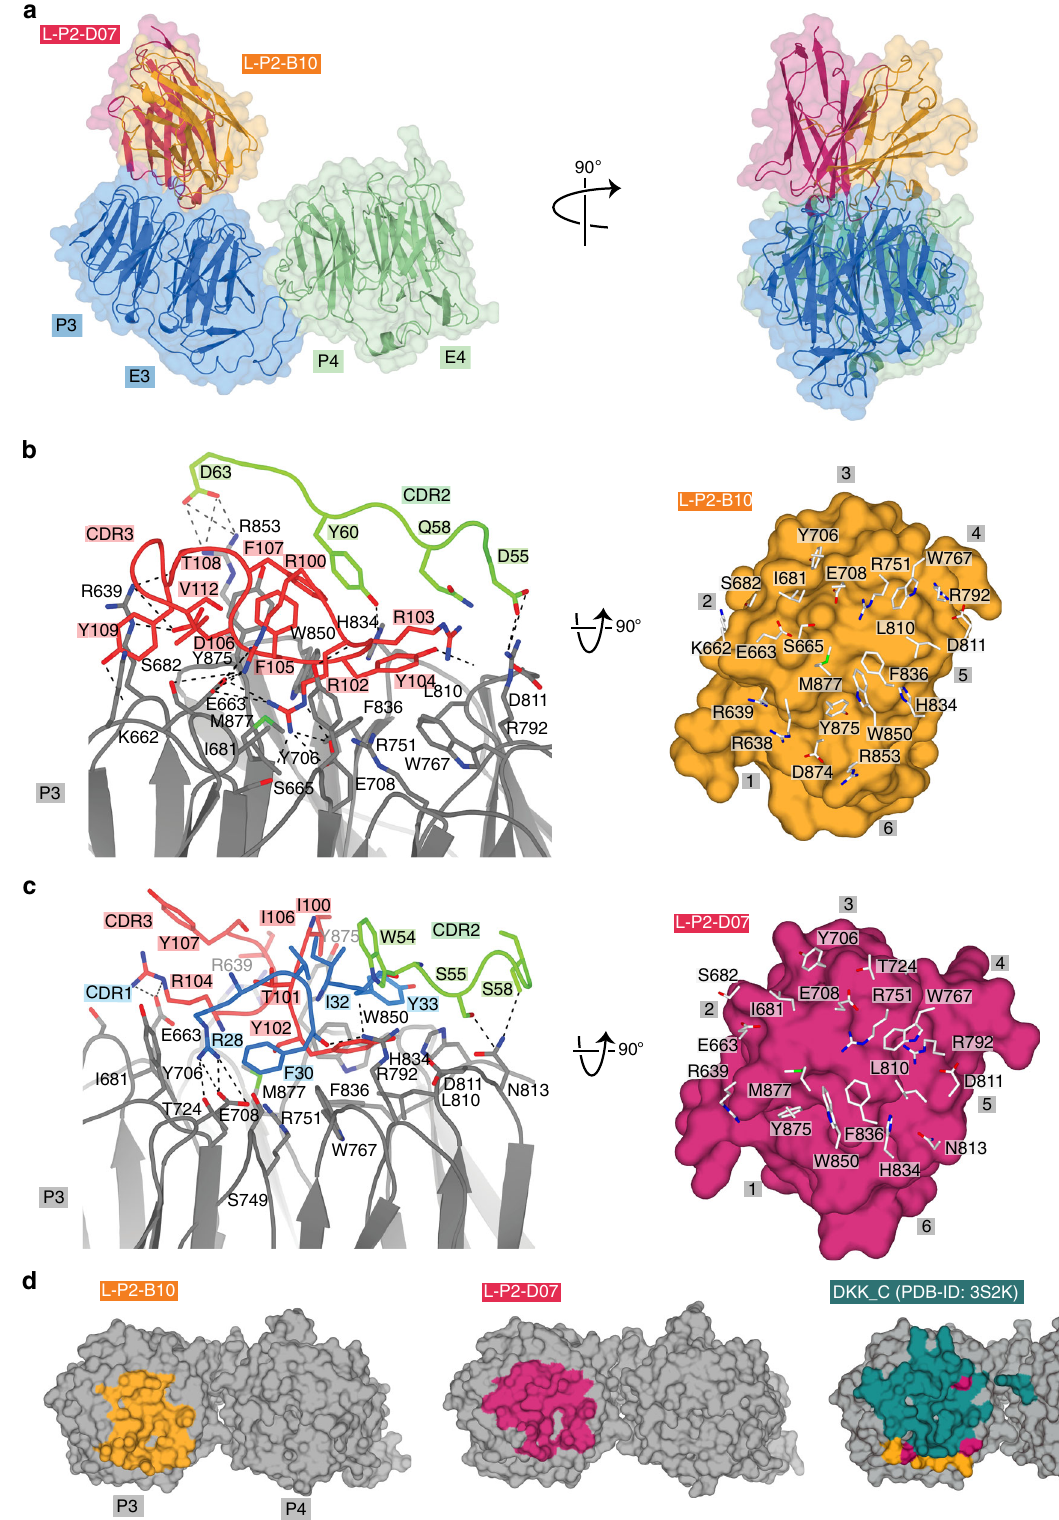
Fig. 3 Structural analysis of L-P2-B10 and L-P2-D07 anti-LRP6 binding mode. a Alignment of the LRP6 P3E3P4E4 complexes with L-P2-B10 and LRP6 – L-P2- D07 in two orthogonal views. Cartoon trace with transparent surface representation of LRP6 P3E3 (blue), LRP6 P4E4 (green), L-P2-B10 (orange) and L-P2- D07 (red). b Interface of LRP6 – L-P2-B10 with on the left-hand side LRP6 P3 (gray) and CDR2 and CDR3 loops of L-P2-B10 (green and red, respectively). Interacting side chains are shown as sticks. On the right side, surface presentation of L-P2-B10 (orange) with interacting residues of LRP6 P3 shown in sticks; numbers represent the six blades of β -propeller 3. c Interface of LRP6 – L-P2-D07 complex, presented similar to b , with in addition the CDR1 loop in blue (left) and the surface of L-P2-D07 in red (right). d Binding-surface areas of L-P2-B10 (orange), L-P2-D07 (red) and DKK-C 31 (magenta) on LRP6 P3E3P4E4